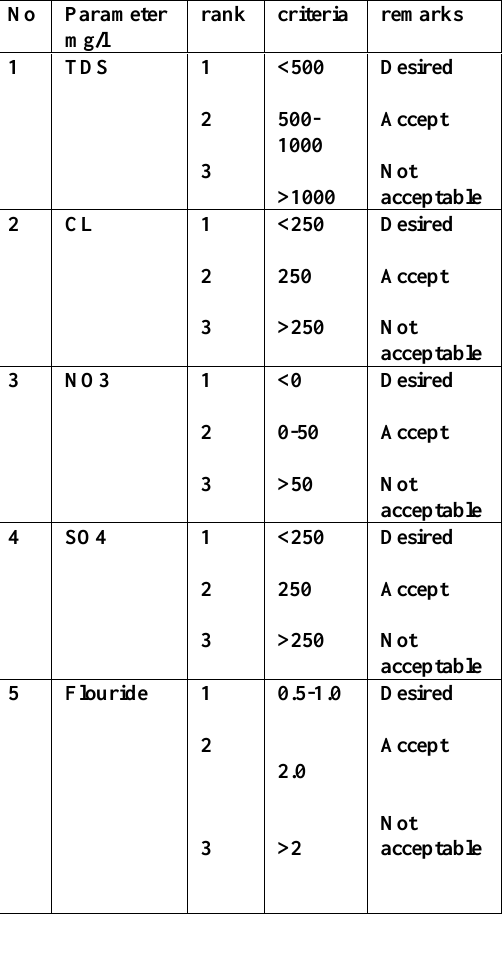
Table (2) Criteria for acceptability and